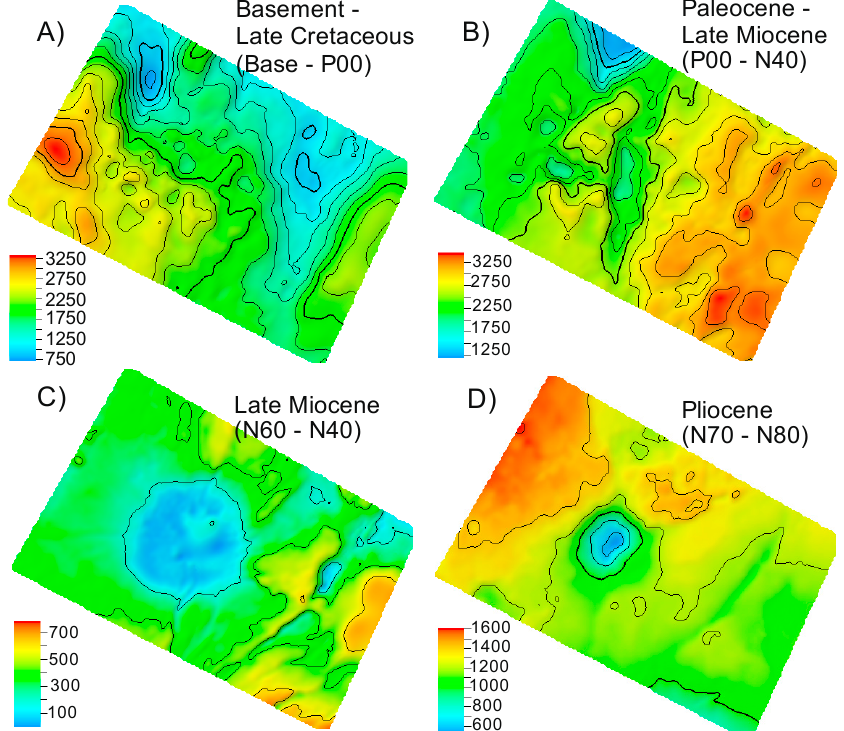
Figure 9. Isopach maps showing the thickness of key intervals that represent the major sedimentary and tectonic stages in the northern Taranaki Basin. ( A ) Basement-P00: syn-rift stratigraphic unit; ( B ) P00–N40: post-rift stratigraphic unit; ( C ) N60–N40: foreland basin stratigraphic unit; ( D ) N70–N80: progradational system. Contour line increment 200 m.